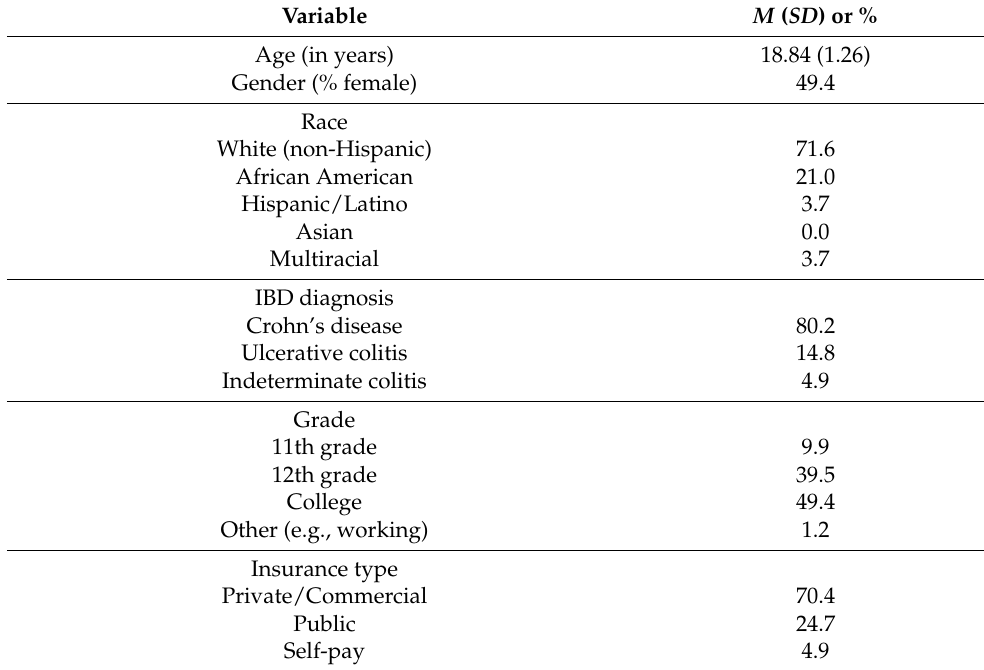
Table 1. Participant